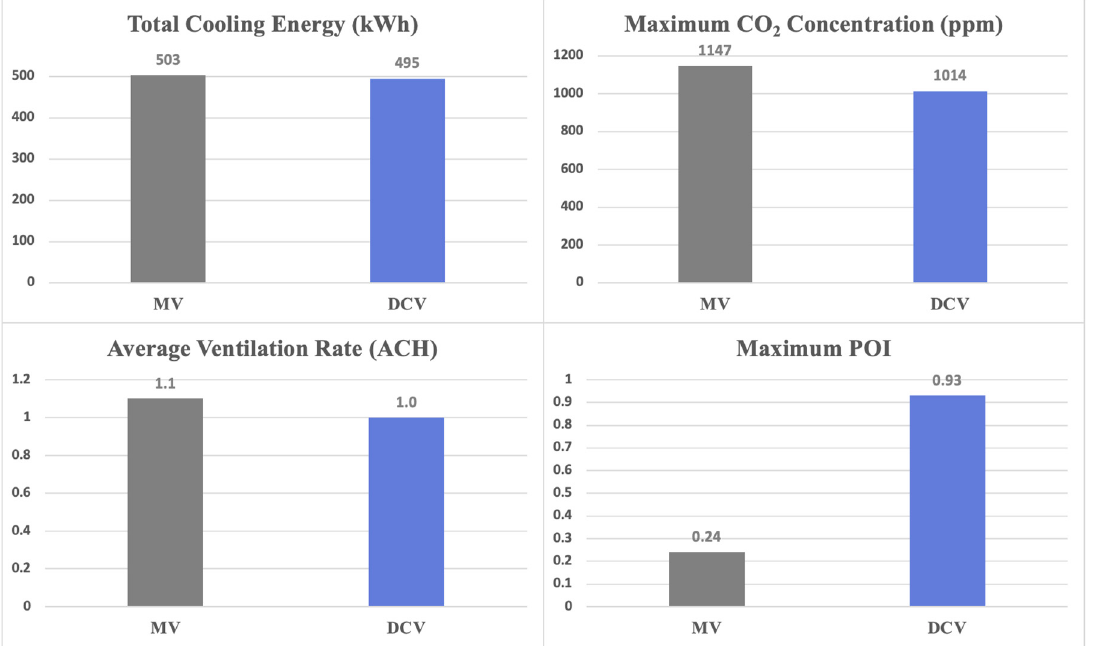
Figure 7. Daily performance indicators of cooling energy use, CO 2 concentration, and POI for MV and DCV speci fi c to July 22 nd .